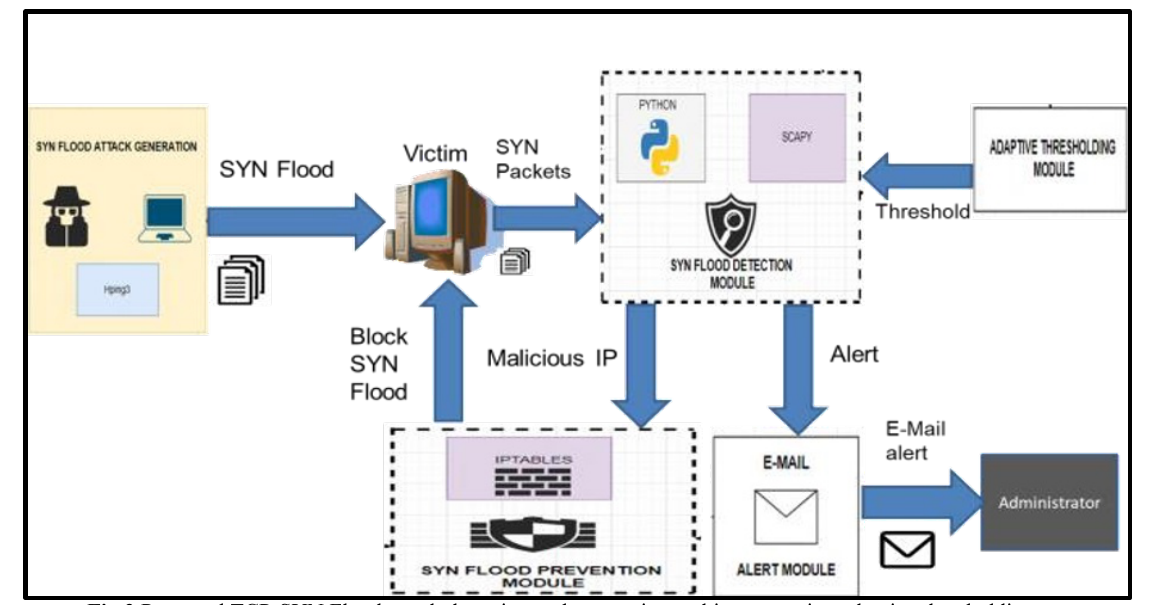
Fig.3 Proposed TCP-SYN Flood attack detection and prevention architecture using adaptive thresholding .